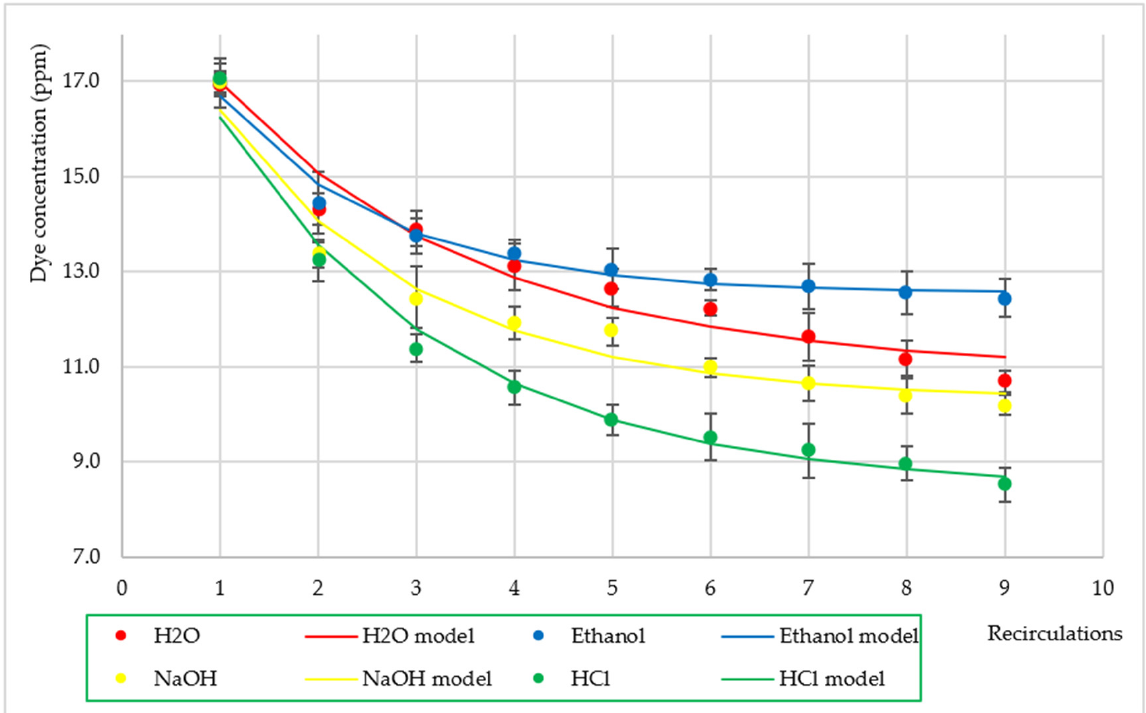
Figure 1. Variation of RB5 concentration (ppm) after dye removal test for different pretreatments. Values adjusted by exponential decay model.